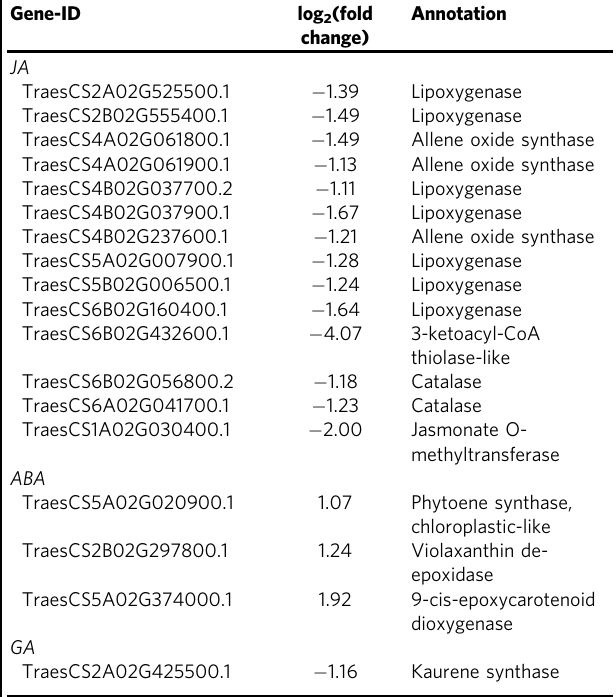
Table 2 List of differential genes involved in plant hormone metabolism between tgw1 and